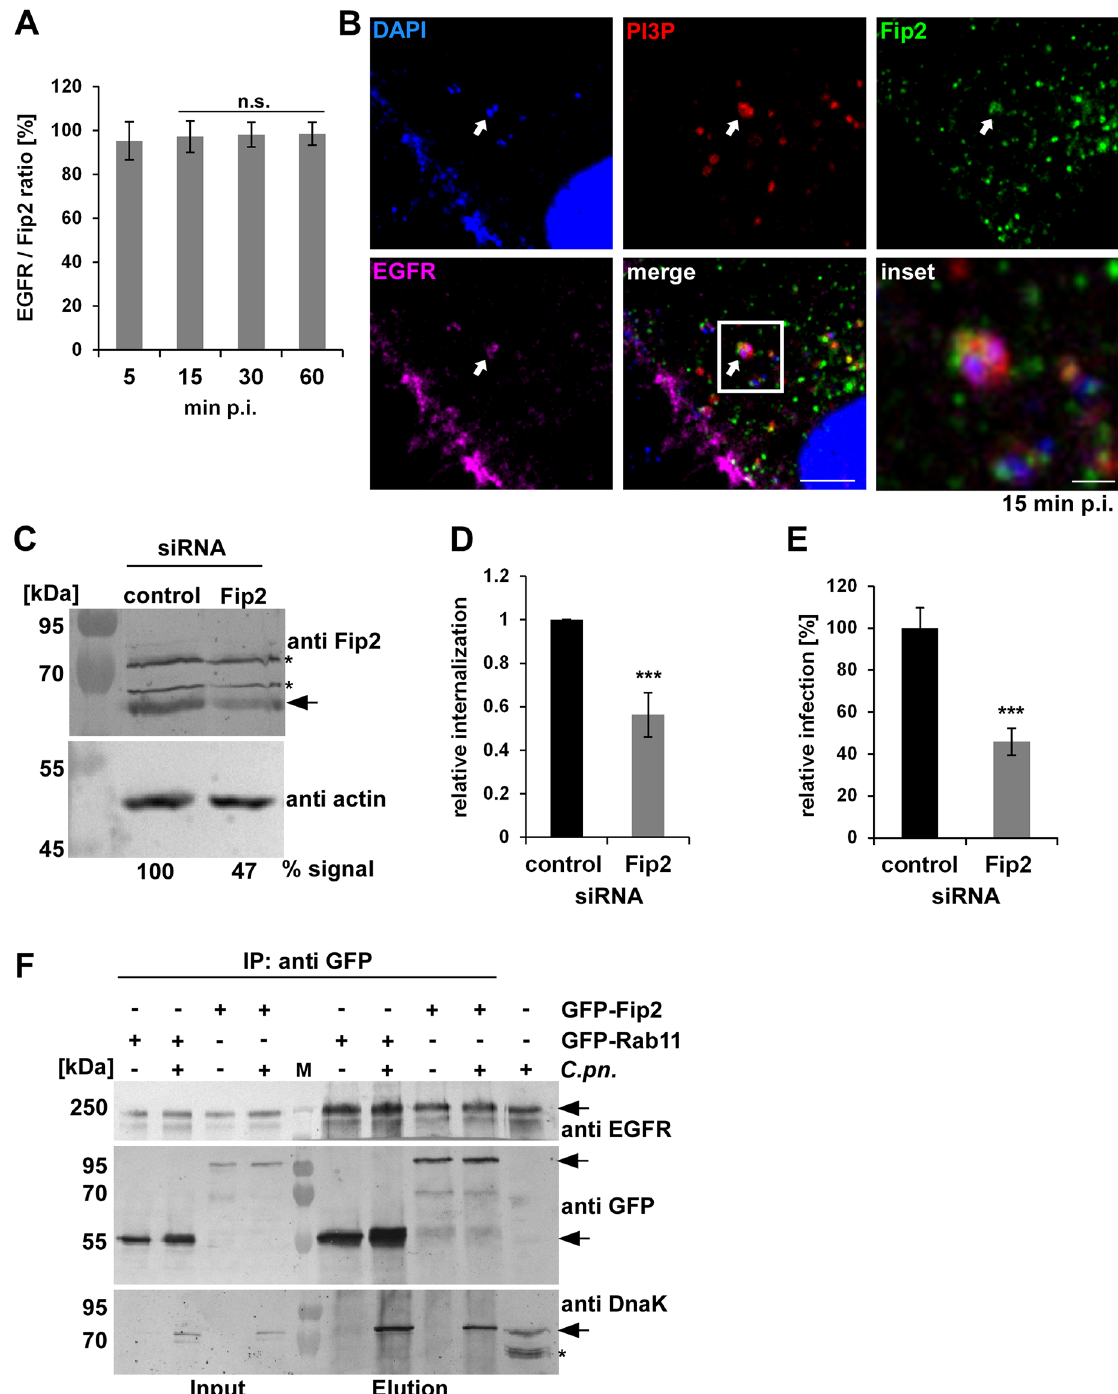
Fig 4. The Rab11/Rab14 adaptor Fip2 is recruited to early C . pneumoniae inclusions. (A) Quantificationof colocalization of Fip2 and EGFR with chlamydial EBs at 5–60 min p.i. in cells transiently transfected with GFP-Fip2 (n = 3). (B) Confocal images of colocalization of EBs (stainedby DAPI) with GFP-Fip2, PI3P and EGFR (visualizedby mCherry-FYVE and anti EGFR and anti- rabbit Alexa647,respectively) at 15 min p.i. White arrows indicatecolocalization, the white box marks the area enlargedin the inset. Bar 10 μ m. Bar in inset 1 μ m. (C) Immunoblotanalysisof cells transiently transfected for 72 h with control or Fip2 siRNA. Samples were lysed in phospho-Lysis buffer, subjectedto SDS/PAGE and probedwith antibodiesagainstFip2 to monitor knockdown; β -actin served as the loadingcontrol. The pixel intensity of bands was analyzedwith ImageJ. The arrow marks the